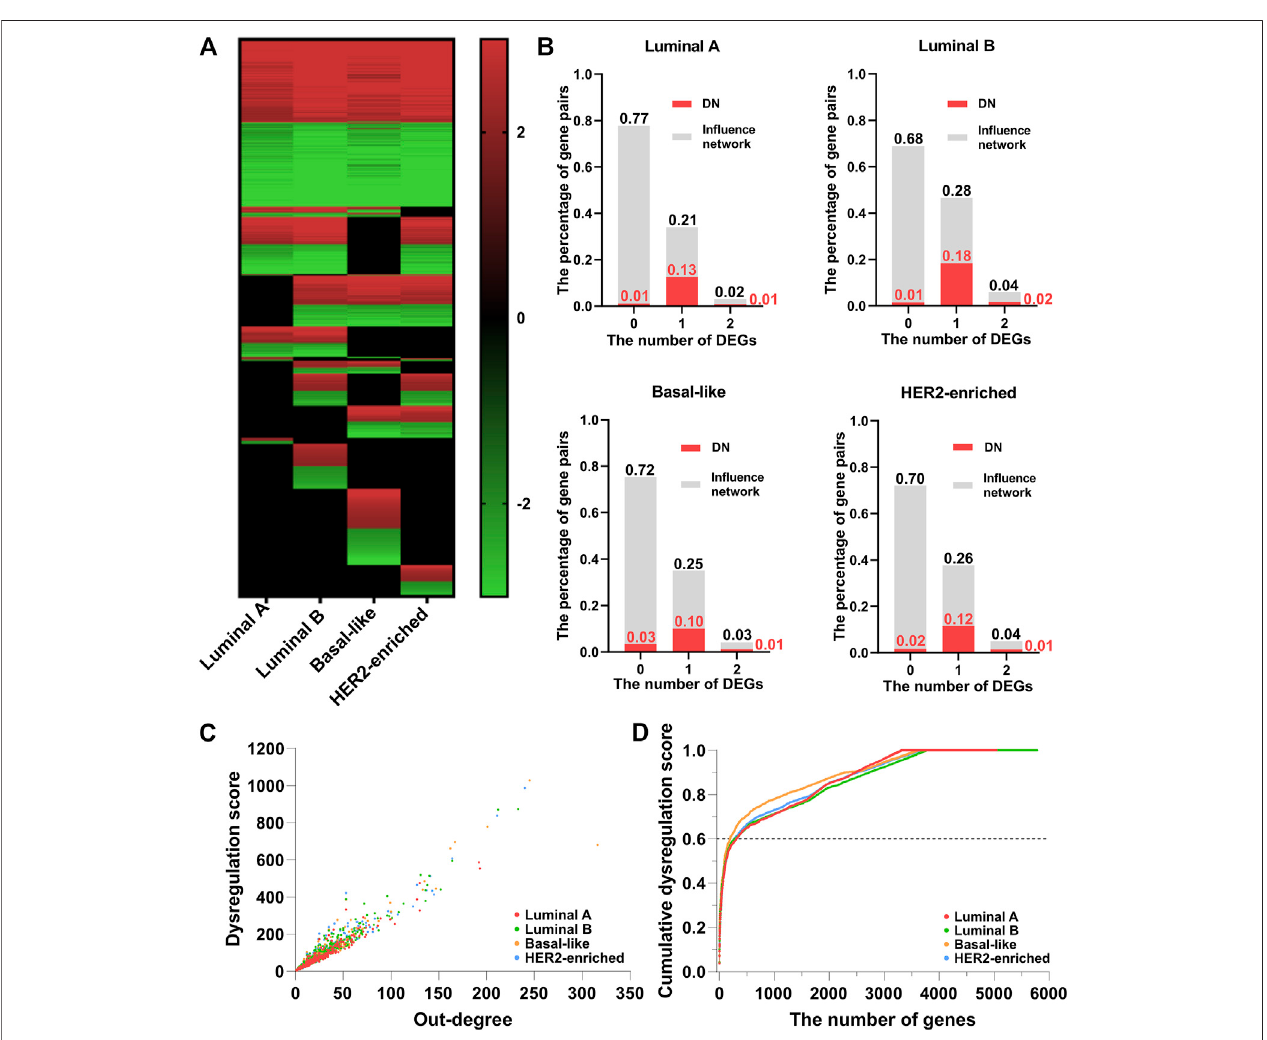
FIGURE 2 | The dysregulated network (DN) of breast cancer. (A) The heatmap of the dysregulated interactions in the four breast cancer subtypes. (B) The percentage of interactions with 0, 1, and 2 DEGs (gray color) and dysregulated interactions (red color) in the background in fl uence network. (C) The scatter plot of the dysregulation score and out-degree of genes in the DN. (D) The relationship between the cumulative dysregulation score and the number of genes in the